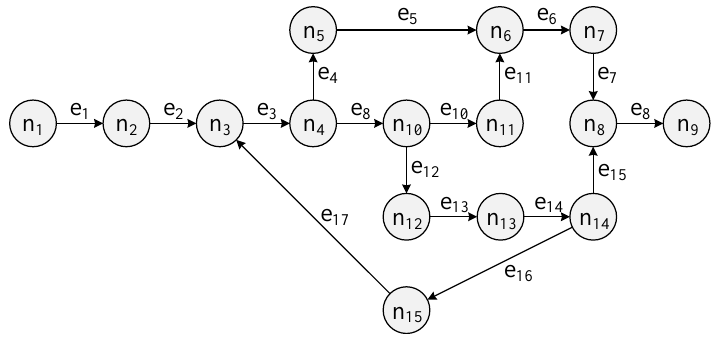
Figure 3. A control-flow